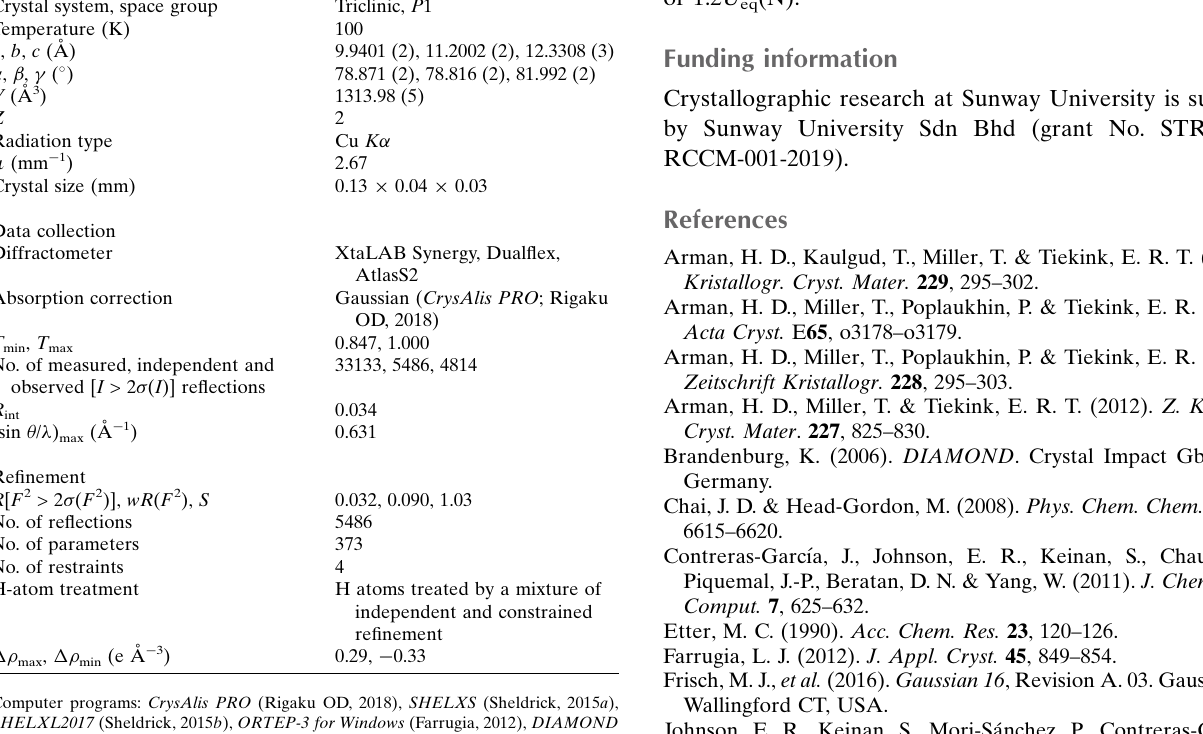
Table 4 Experimental details. Crystal data Chemical